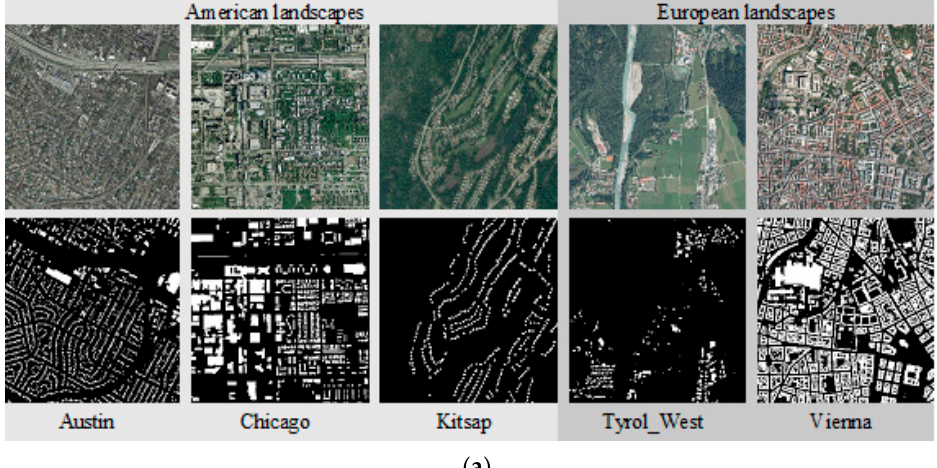
Table 1. The number of samples for training, validating, and testing from our UAV